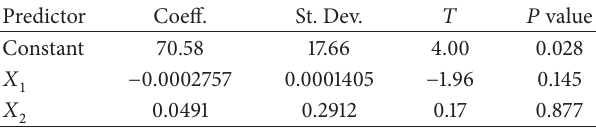
Table 8: Table of results from regression analysis. Predictor Coeff.